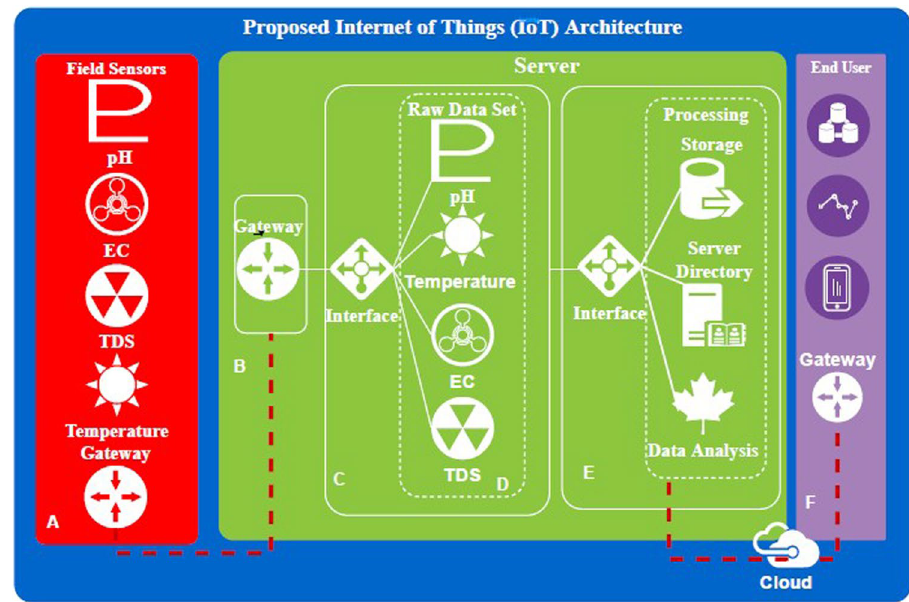
Fig. 2 Components of IoT Architecture